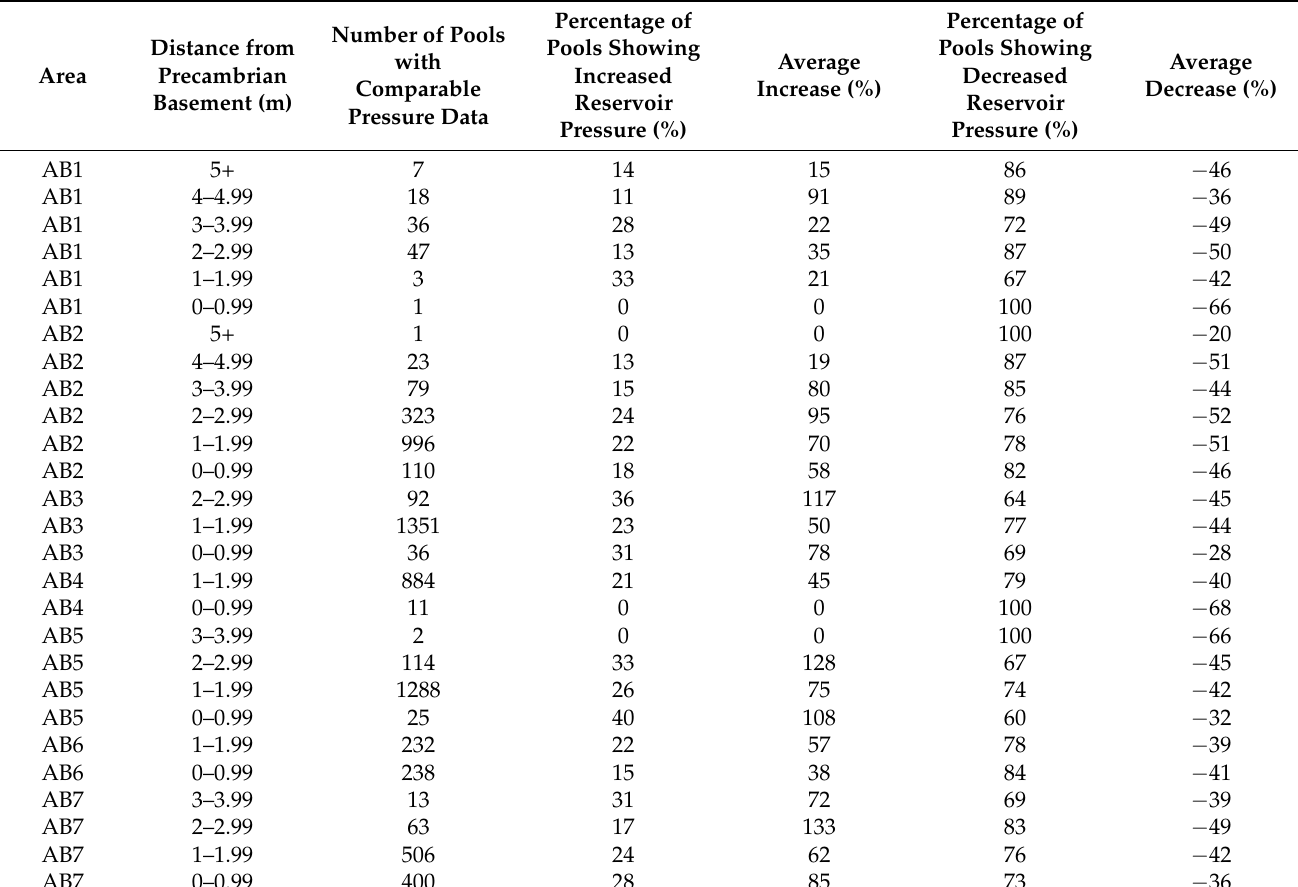
Table 3. Calculated reservoir pressure-change in select pools in the Alberta Basin (1960–2020). Source data extracted from geoLOGIC Systems databases ©